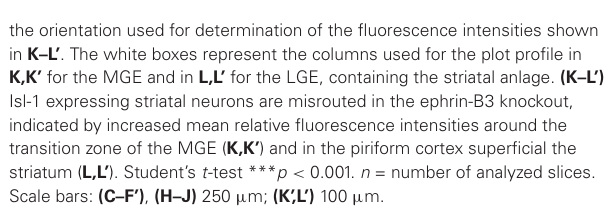
FIGURE 7 | Continued The same result was found for calbindin positive neurons at E14 ( D ) and E16 ( E ). (F, F’) Overlay of calbindin and DAPI staining of a coronal slice at E16 at the region of the striatum in the wild type ( F ) and in the ephrin-B3 knock out ( F’ ) indicating ectopic cells in the striatum. (G) Quantitative analysis of the area of stained Isl-1 + cells of E14 wildtype and ephrin-B3 knock out coronal slices as shown in H and I . The white region marks the measured immunoreactive area. (J) Isl-1 immunostaining of a coronal E14 WT slice in